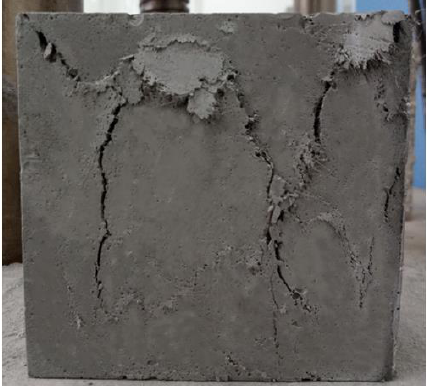
Figure 1: Failure mode of test specimens. Figure 2: Influence of Changes in Factors on Compressive Strength.